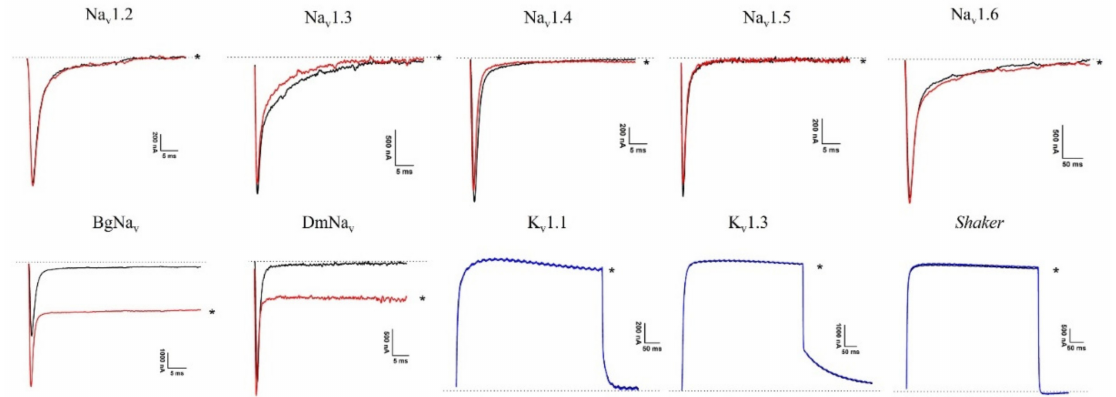
Figure 10. Electrophysiological profiles of L. geometricus venom fraction 14 on Na v and K v channels. Panels show superimposed current traces of 0.4 µ g/ µ L fraction 14. Black indicates a current trace in control conditions; red or blue indicates a current trace in toxin situation. The dotted line indicates zero current level. The asterisk marks steady-state current trace after application of toxin.